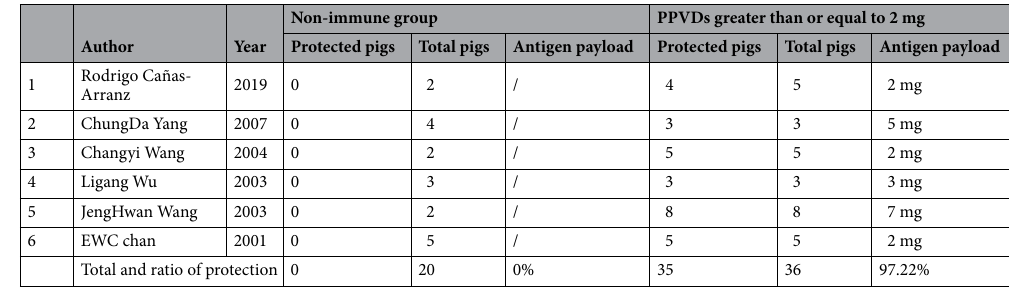
Table 3. Number of animals protected by PPVDs greater than or equal to 2 mg group and the non-immune